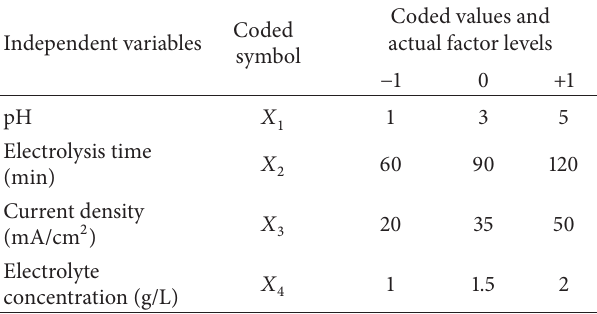
Table 2: Ranges of independent variables and their